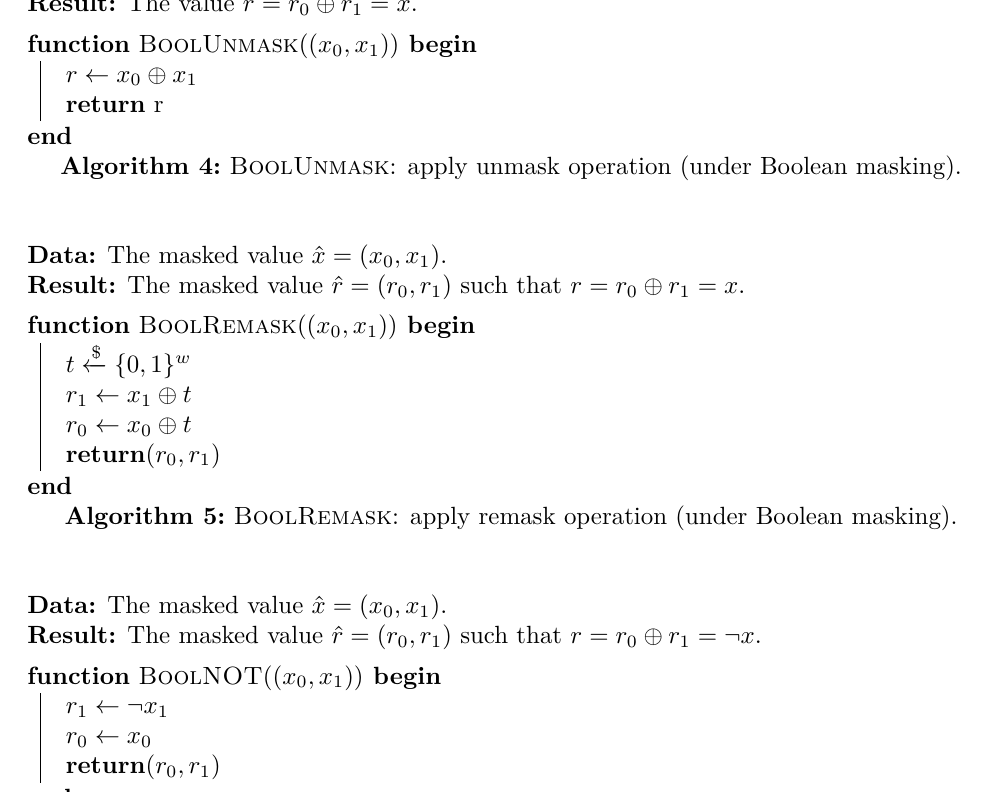
Algorithm 6: BoolNOT : apply NOT operation (under Boolean masking).